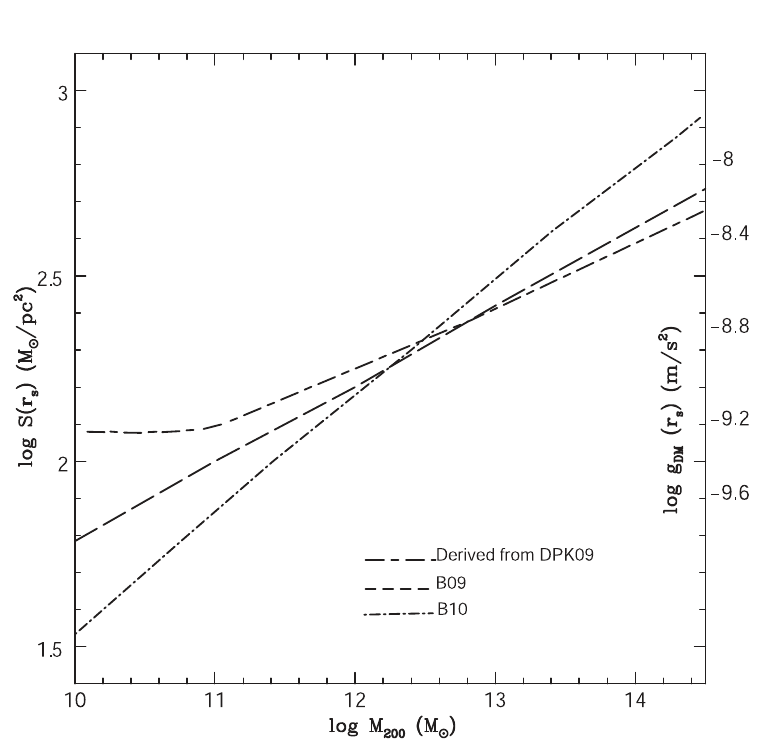
Fig. 2. S ( r s ) as a function halo mass M 200 . The long dash - short dash line, dashed line, and the dot-dashed line represent S ( r s ) for the model of this paper, B09, and B10,